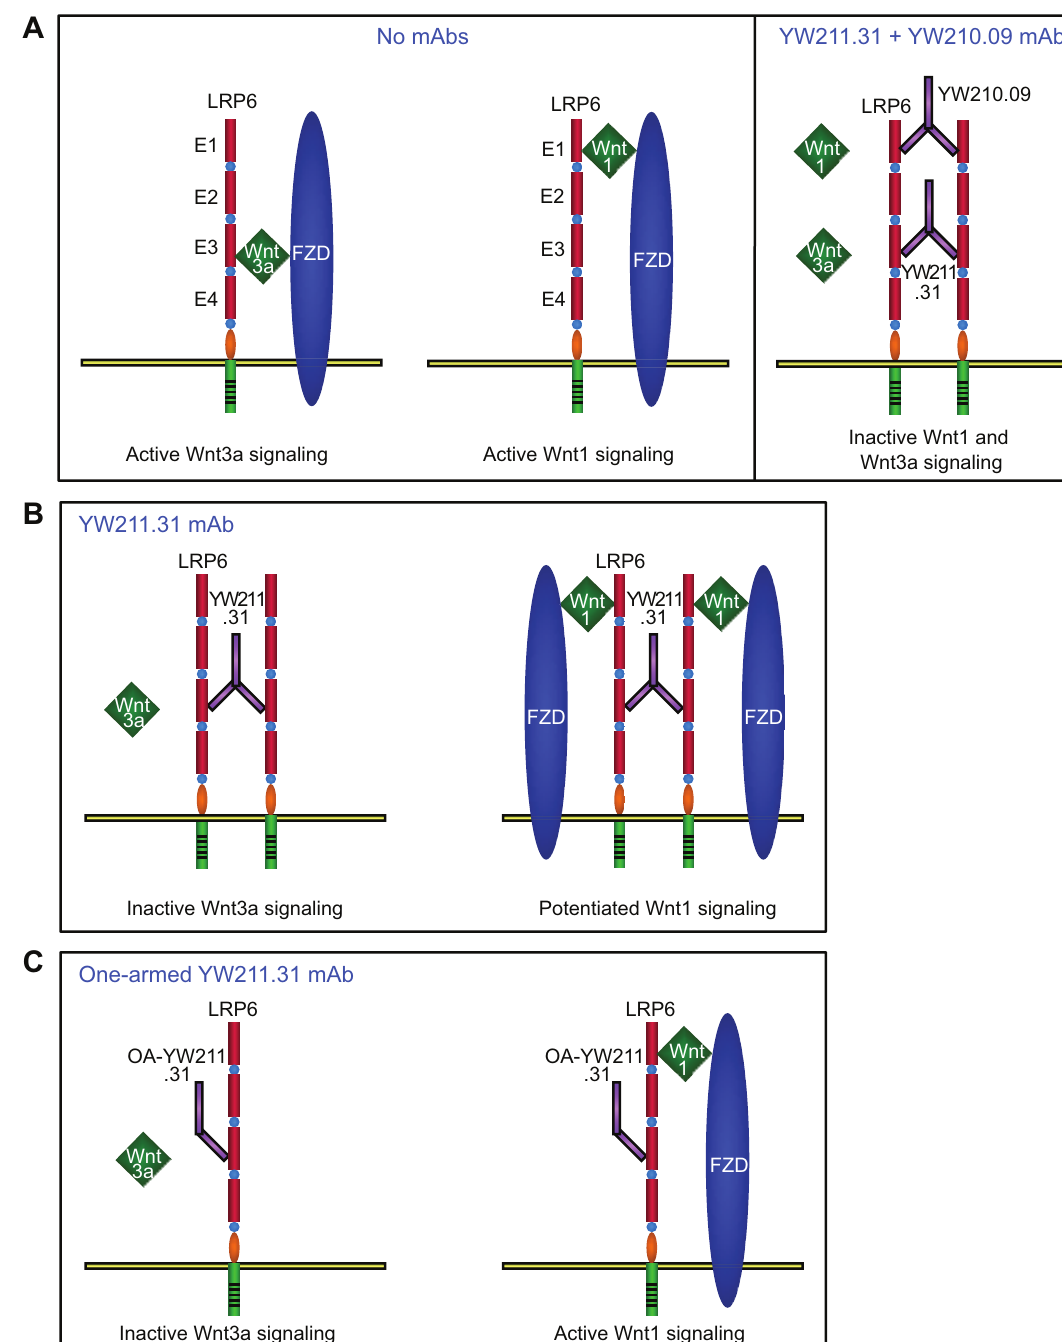
Figure 8. Model of LRP6 interactions with antibodies and Wnt isoforms. (A–B) Wnt3a and Wnt3 induce signaling by binding the E3-E4 region of LRP6 and recruiting FZD into the complex, whereas Wnt1, Wnt9b, and other Wnt isoforms in this class (Figure 3C) bind the E1-E2 region. YW211.31.57 and YW210.09 antibodies recognize LRP6 regions E3-E4 and E1-E2, respectively, to inhibit signaling by only the Wnt isoforms that bind these regions. Both antibodies can bind an LRP6 molecule simultaneously to antagonize signaling in the presence of Wnt isoforms from both classes. Each antibody can potentiate signaling by the class of Wnt isoforms that bind regions outside its epitope, through crosslinking coreceptors and allowing Wnt to recruit FZD. (C) A one-armed antibody can inhibit signaling by blocking Wnt binding, but cannot potentiate since it does not dimerize LPR6.